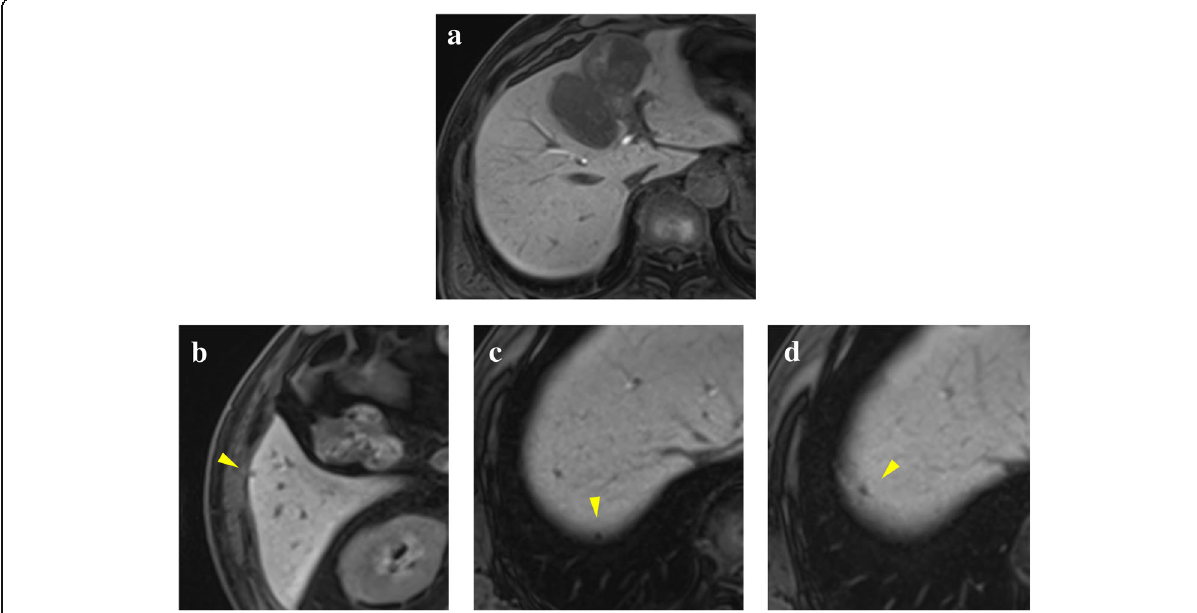
Fig. 3 Gadolinium-enhanced magnetic resonance imaging findings. In addition to main tumor in S3+4 ( a ), small nodules that represented enhancement defect in the hepatocyte phase were detected in S6 (2 b ), S7 (2 c ), and S8 (2 d )